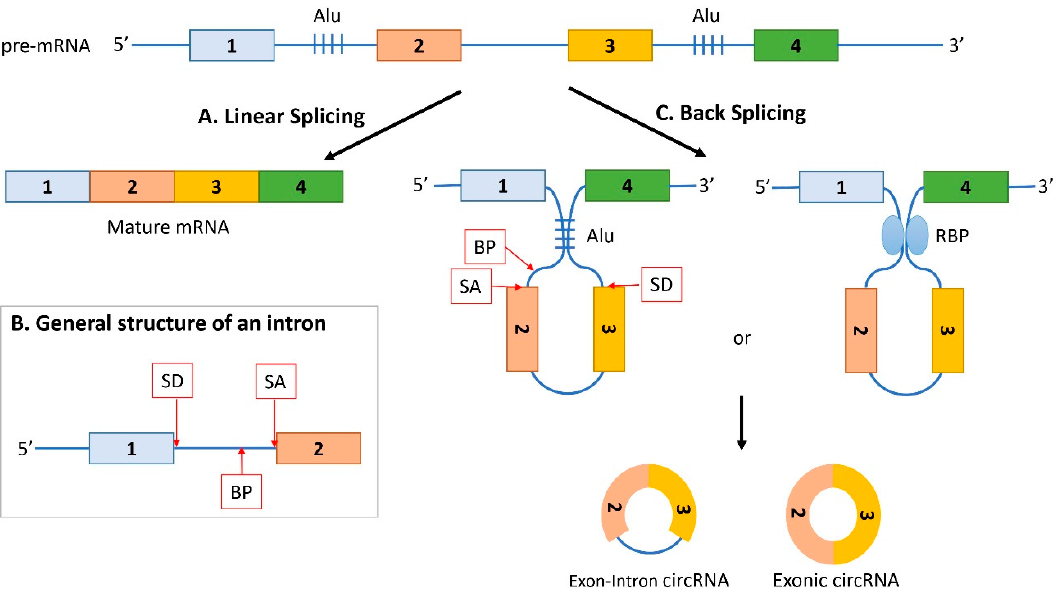
Figure 1. Generation of circRNAs by back splicing. ( A ) The immature pre-mRNA undergoes linear splicing where introns are removed, and exons are linearly joined to form the mature mRNA. ( B ) Introns contain different important sites for the splicing reaction: The splice-donor site (SD) at the 5’ left end, the splice-acceptor site (SA) at the 3’ right end, and the branch point (BP). ( C ) The immature pre-mRNA undergoes back splicing when there is a formation of a loop between the intron sequences flanking the downstream SD site and the upstream SA site. The formation of the loop is promoted by base pairing between inverted repeat elements of the flanking introns, such as Alu elements (Alu) or by the dimerization of RNA-binding proteins (RBP) that specifically bind to the flanking introns. Consequently, an upstream BP extends to a downstream SD site and allows the formation of a covalent binding between the 5 ′ site of an upstream exon and the 3 ′ end of a downstream exon, creating an Exon-Intron circRNA. If the intron is spliced-out from a transient Exon-Intron circRNA, or the covalent binding occurs between the 5 ′ site of an exon with the 3 ′ of the same exon, an Exonic circRNA originates.